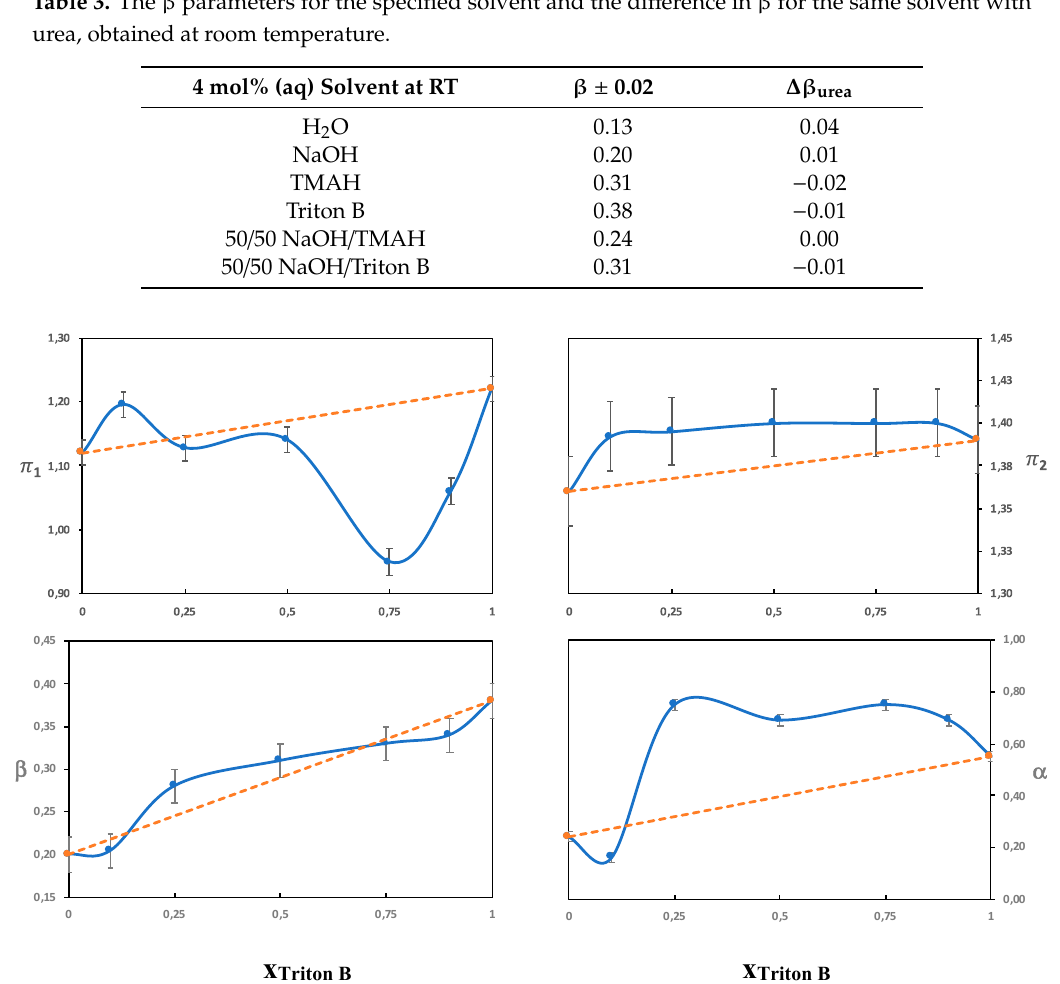
Table 3. The β parameters for the specified solvent and the di ff erence in β for the same solvent with urea, obtained at room temperature.